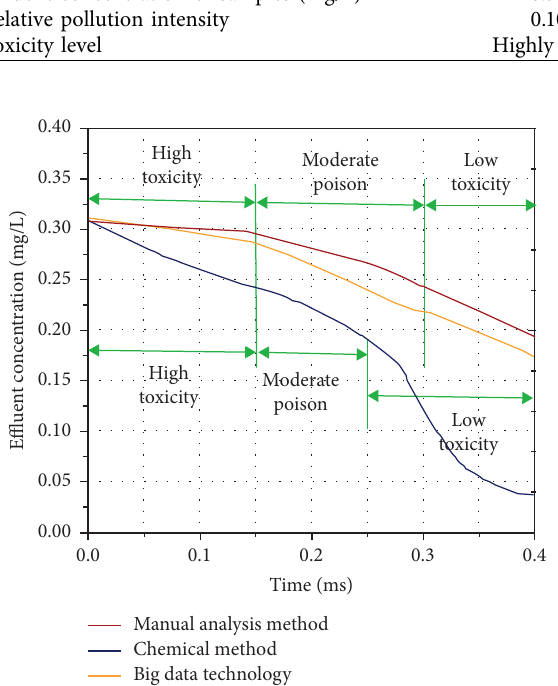
Figure 6: Changing situation of the toxicity of pollutants with large particle size under different analysis methods.